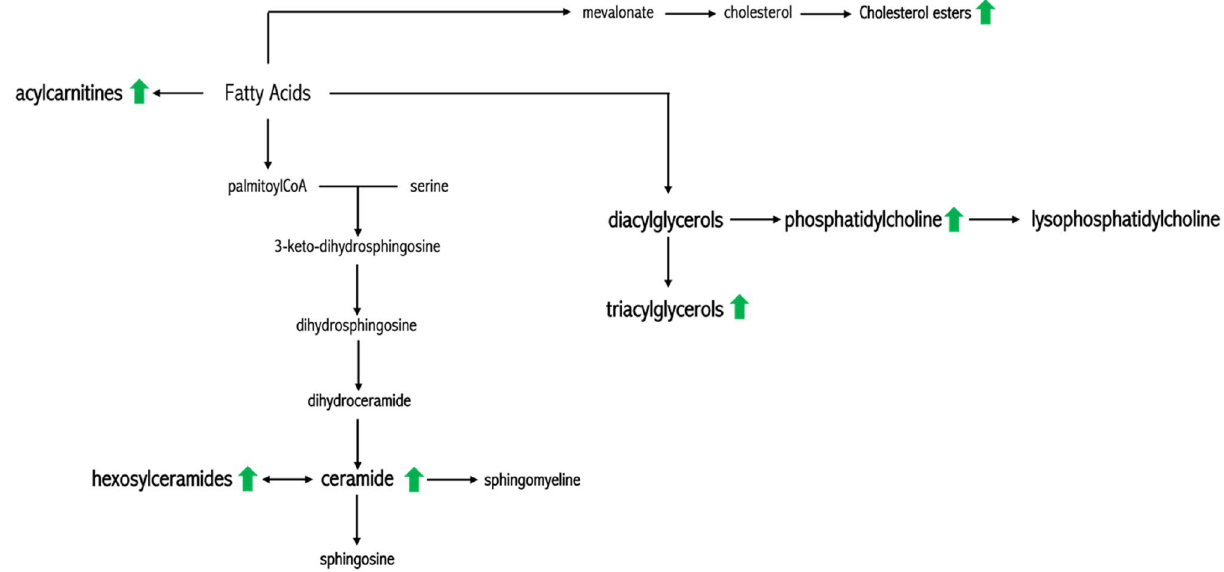
Figure 8. Summary of lipid biosynthetic pathways. Green arrows represented the more abundant lipid classes in CF